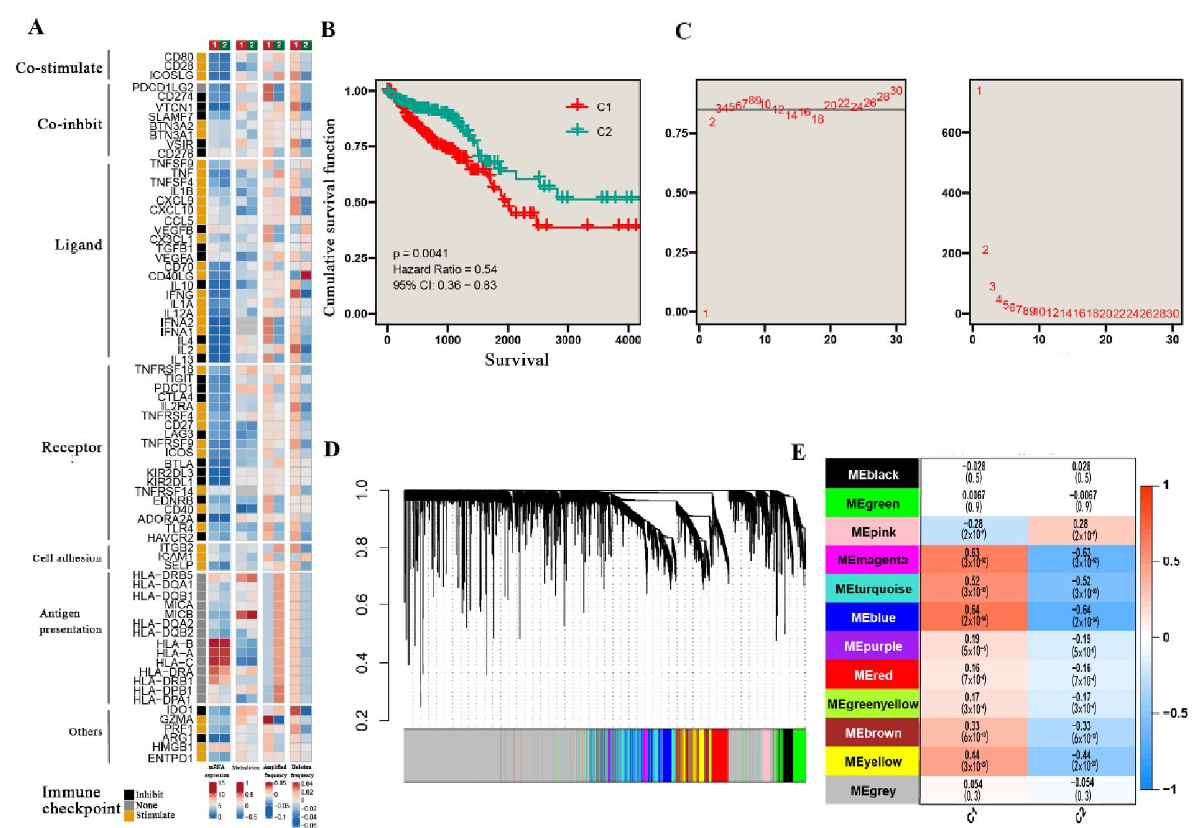
Figure 1. The differences between two subtypes of CRC. ( A ) The comparison of the immune checkpoint-related gene expression, methylation, and mutation correlation between C1 and C2 subtypes. ( B ) Survival outcome differences between two subtypes. ( C ) The soft domain value and mean connectivity setting for WGCNA. ( D ) Cluster dendrogram of WGCNA. ( E ) The correlation between gene modules and subtypes. Table 1. Univariable and multivariate analysis of risk factors for CRC.